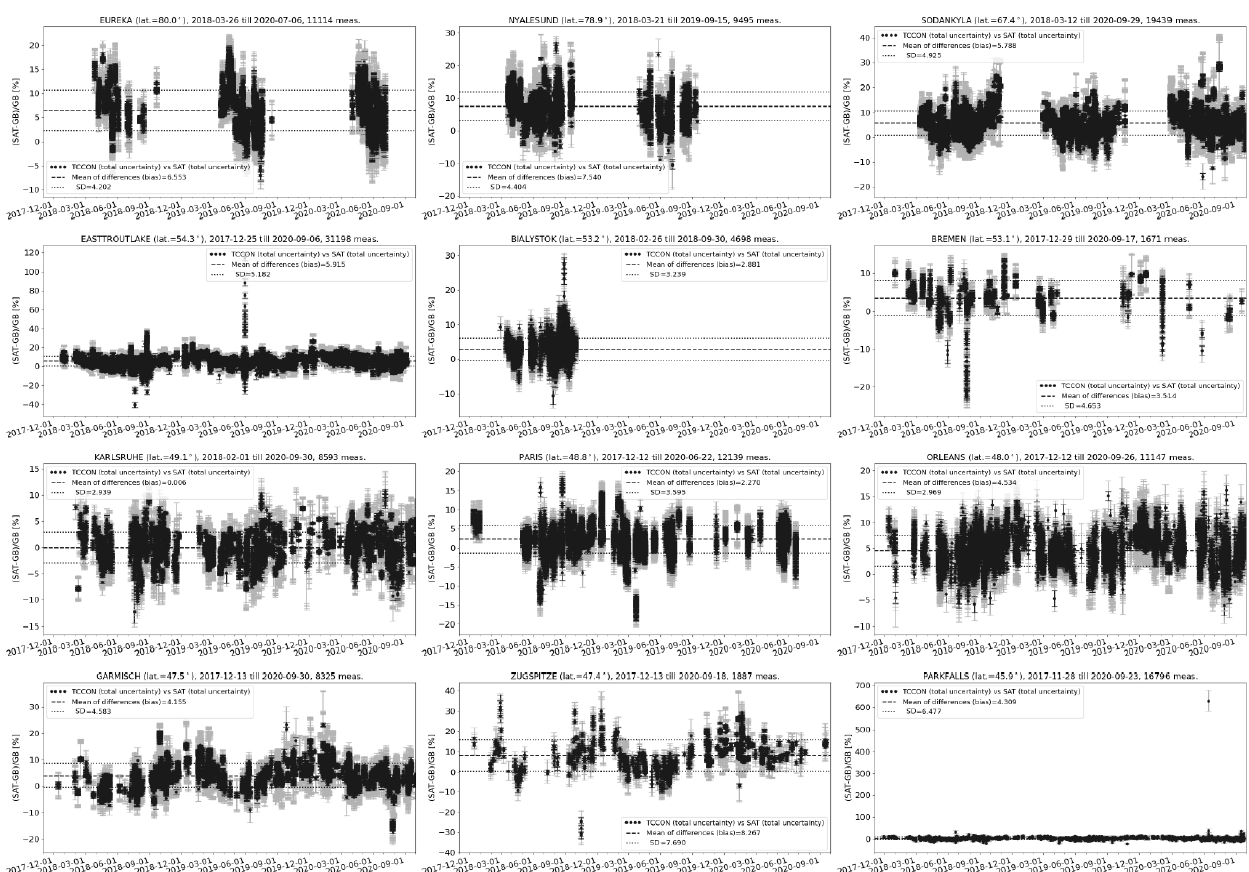
Figure 21. Relative difference ((satellite − ground-based)/ground-based) of XCO time series for all co-located S5P data and unscaled TCCON data with a priori alignment as the reference data at each site ordered with decreasing latitude as in Fig. 19. Spatial co-location with radius of 50km and time of ± 1h around the satellite overpass was